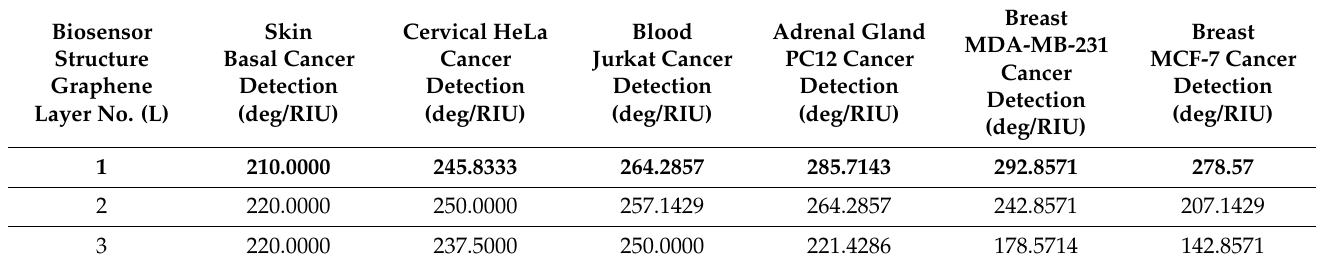
Figure 9. Analysis of the graphene layer for the proposed BK 7 /TiO 2 /Au/graphene biosensor. Table 5. Analysis of graphene layers on the angular sensitivity of the proposed BK 7 /TiO 2 /Au (50 nm)/graphene/analyte biosensor for cancer detection.